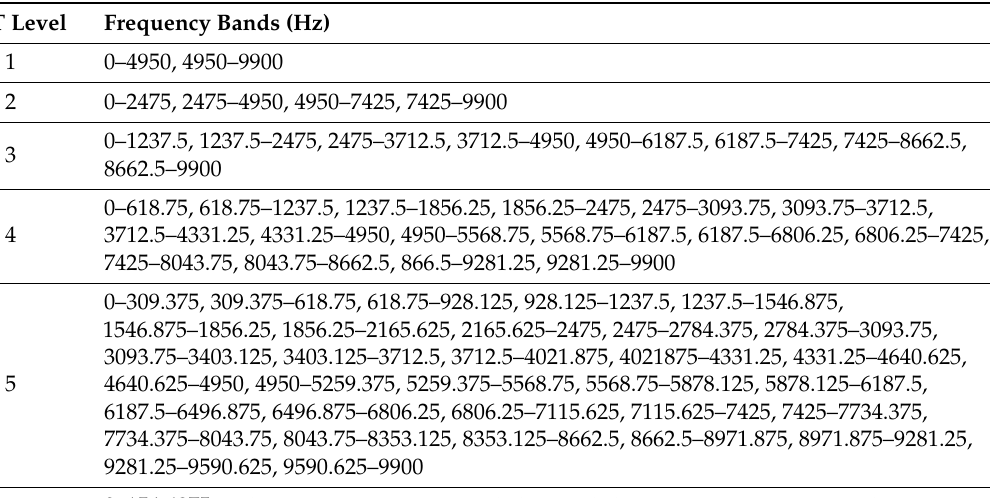
Figure 6. The PCC voltage and current signals once the local loads match with local generation. Table 2. Frequency bands of each level.